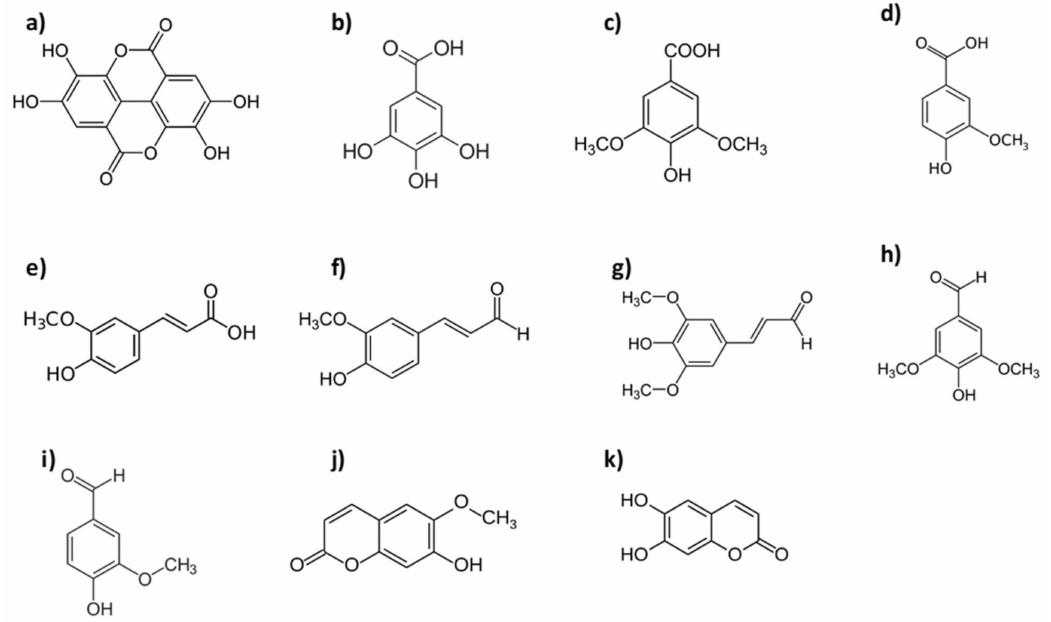
Figure 2. The main low molecular weight phenol (LMWP) identified in oaks: acids: ( a ) ellagic, ( b ) gallic, ( c ) syringic, ( d ) vanillic, ( e ) ferulic; aldehydes: ( f ) coniferyl, ( g ) sinapic, ( h ) syringic, ( i ) vanillin; coumarins: ( j ) scopoletin, ( k ) aesculetin. (https: // en.wikipedia.org / wiki /